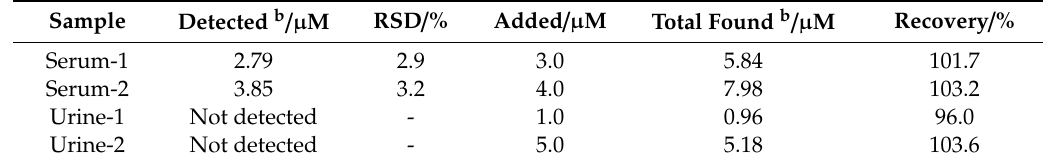
Table 3. Detection of Trp in the human serum and urine samples ( n a =